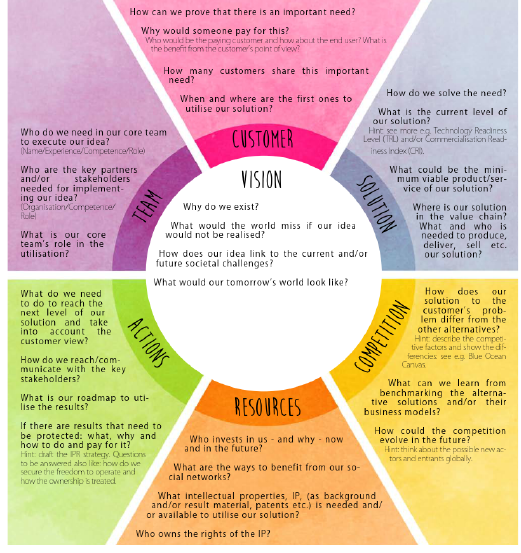
Fig. 1. The layout of the Impact Canvas® tool 5